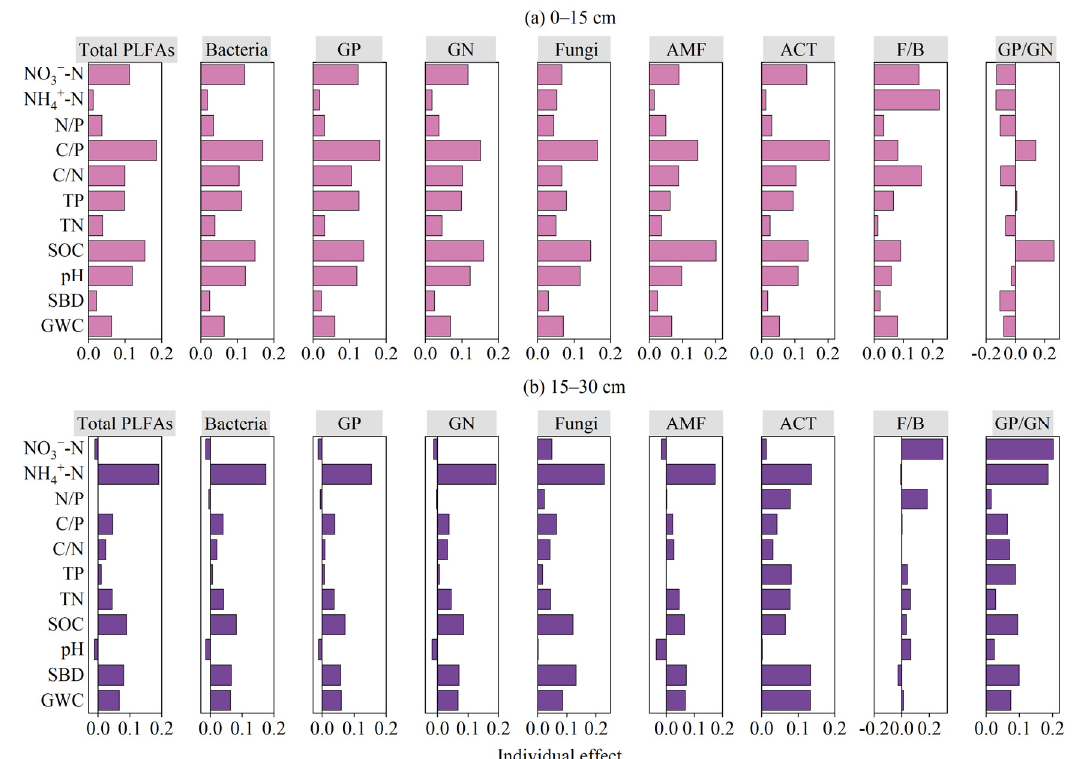
Figure 4. The relative importance of soil physicochemical properties on soil microbial communities was determined for ( a ) 0–15 cm and ( b ) 15–30 cm soil depths using hierarchical partitioning analysis. The individual effect is used to compare the difference in the proportion of response variables explained between explanatory variables (relative importance), and each variable’s individual effects (as determined by hierarchical partitioning) are connected to the sum of its unique and total average shared effects (calculated using variation partitioning) [39]. Abbreviations: actinomycetes (ACT), arbuscular mycorrhizal fungi (AMF), Gram-positive bacteria (GP), Gram-negative bacteria (GN), nitrate nitrogen (NO 3 − -N), ammonium nitrogen (NH 4+ -N), total phosphorus (TP), total nitrogen (TN), soil organic carbon (SOC), soil bulk density (SBD), and gravimetric water content (GWC). GP/GN, F/B, N/P, C/P, and C/N represent the ratios of Gram-positive bacteria to Gram-negative bacteria, fungi to bacteria, total nitrogen to total phosphorus, organic carbon to total phosphorus, and organic carbon to total nitrogen,